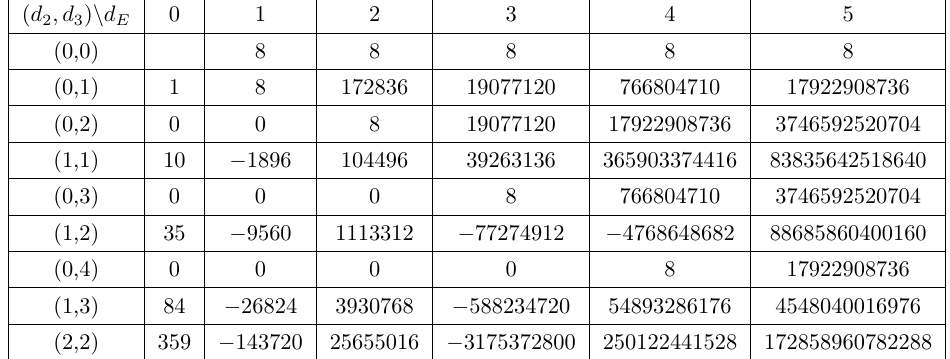
for the genus ( g ) = (1 , 0) L , g R ( d E ,d 2 ,d 3 )